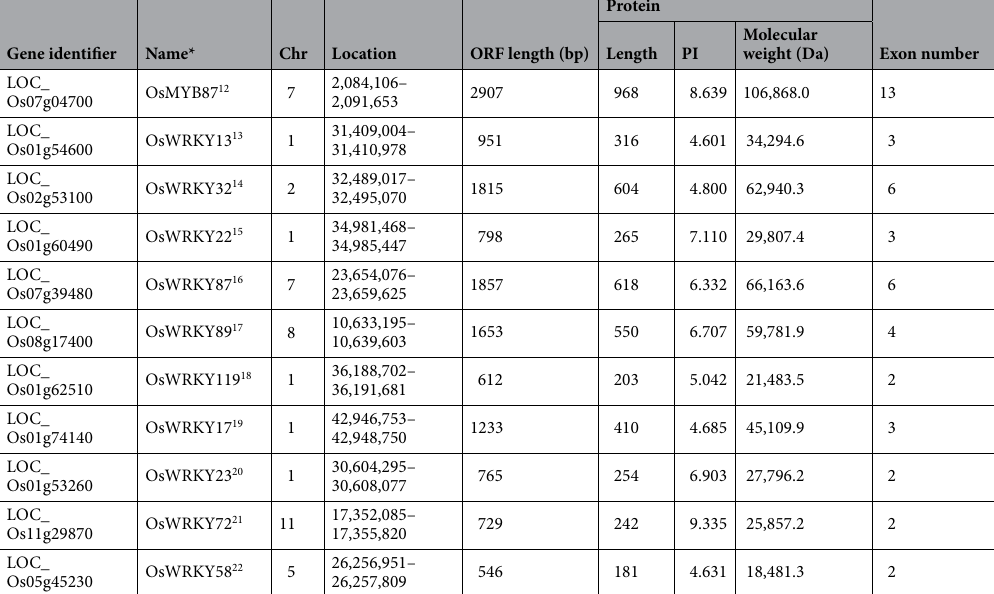
and MYB TF family genes except in the OsMYB50 gene. The MYB binding sites are found in WRKY and MYB genes, with high occurrence in the MYB genes. Other stress-related elements are found in rice genes that include the oxidative stress-responsive element (ARE) and light stress (I-box, Box II and LTR). The elicitor responsive element (W-box), light stress (GT1-motif and GATA-motif) and defense response (G-box) were consistently